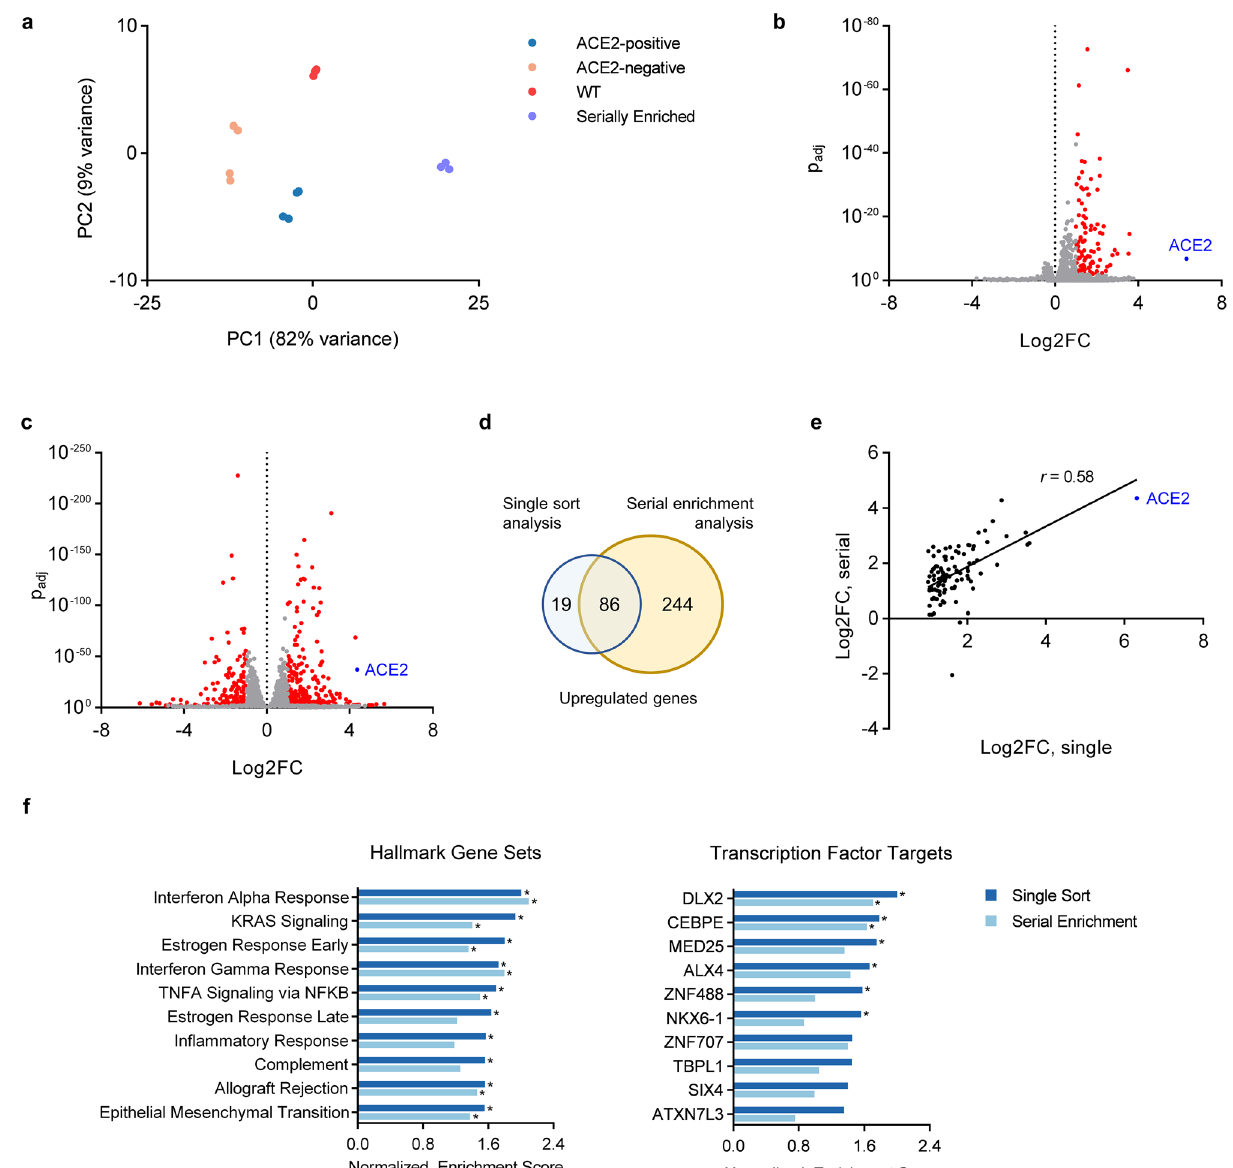
Figure 5. Transcriptome profiling of ACE2-expressing and non-expressing HuH7 cells. ( a ) Principal component analysis of RNA-seq profiles of parental wild-type cells, singly sorted ACE2-negative and ACE2- positive, and serially sorted ACE2-enriched cells. ( b ) Volcano plots of differentially expressed genes between ACE2-negative and ACE2-positive cells isolated after a single sort. Genes exhibiting abs(log2FC) > 1 and p adj < 0.1 by DESeq2 calculation are colored in red. ( c ) Volcano plot of differentially expressed genes in parental HuH7 cells and serially ACE2-enriched cells. ( d ) Venn diagram comparing the number of upregulated genes identified in each of the 2 RNA-seq analyses in ( b , c ). ( e ) Correlation of log2 fold change for each gene upregulated in 5B in comparison to its magnitude of upregulation in ( c ). ( f ) Gene set enrichment analysis depicting the normalized enrichment scores of the 10 most enriched hallmark pathways and transcription factors target sets in singly sorted ACE2-positive cells relative to ACE2-negative cells. The corresponding normalized enrichment score in serially sorted ACE2-enriched cells relative to wild-type cells is also plotted. Asterisk indicates FDR < 25% by GSEA separation of cross-reactive proteins. For flow cytometry, it also remains possible that optimization of our stain- ing protocol (e.g. antibody concentration, blocking or wash conditions) might uncover ACE2-specific binding. Under the conditions of our staining, however, only 2 antibodies tested (R&D #MAB9332 and R&D #AF933) showed clearly significant dependence of binding upon ACE2 expression. Our systematic validation of these antibodies will serve as a resource for researchers interested in either quantifying human ACE2 protein at the single cell level, or in isolating cells based upon their ACE2 protein abundance.